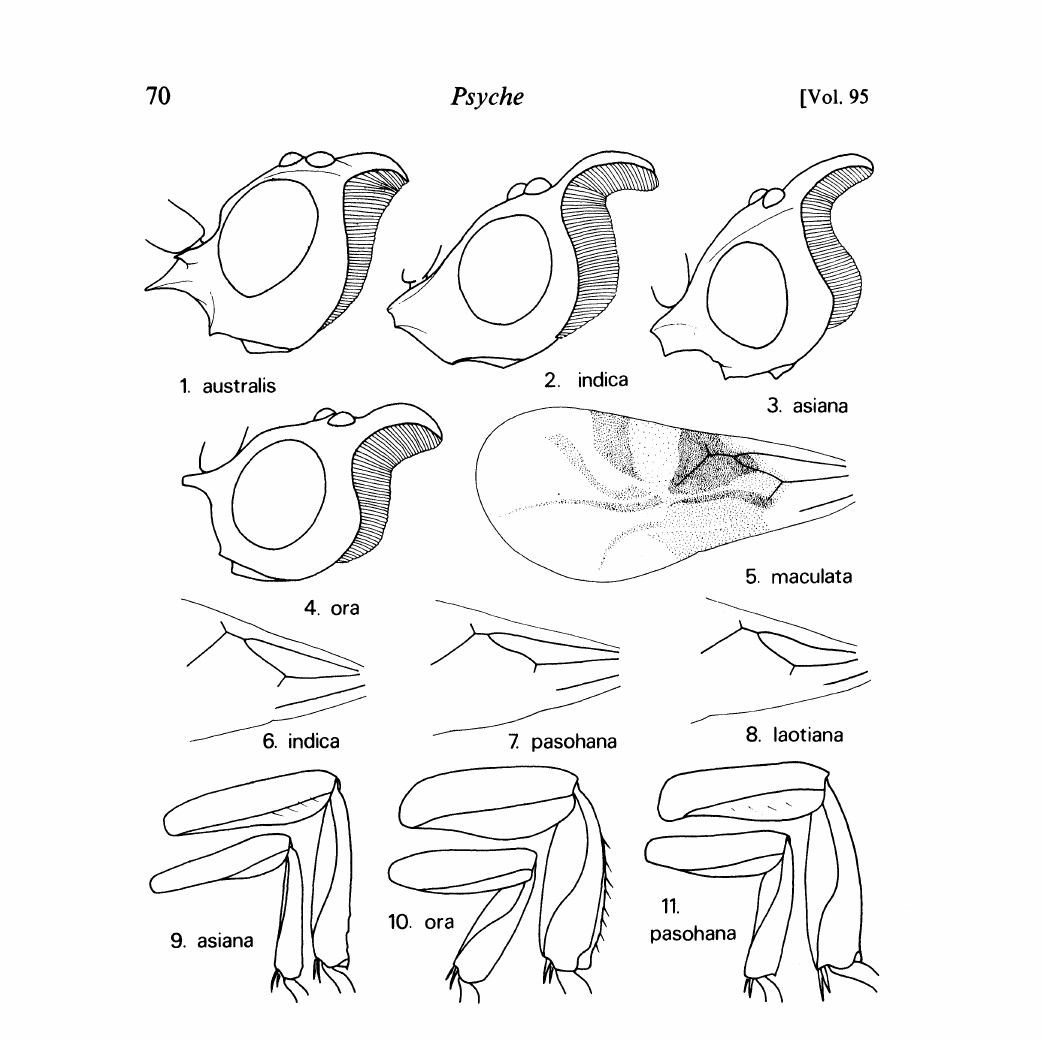
Figs. I-I 1. Loboscelidia species. Figs. 1-4. Lateral view of head. Fig. 5. Fore- wing. Figs. 6-8. Forewing venation. Figs. 9-11. Lateral view of hindleg (above) and midleg (below). with parapsides and notauli nearly complete; propodeal angles broadly rounded, about 1.5 MOD tall; femora and tibiae with numerous macrochaetae; miditibial flange large, extending over two-thirds of tibia; hindfemoral flange large, extending along two- thirds of femur; hindtibial posterior margin bicarinate, flange extending for entire tibial length; forewing (fig. 6), R1 0.6,